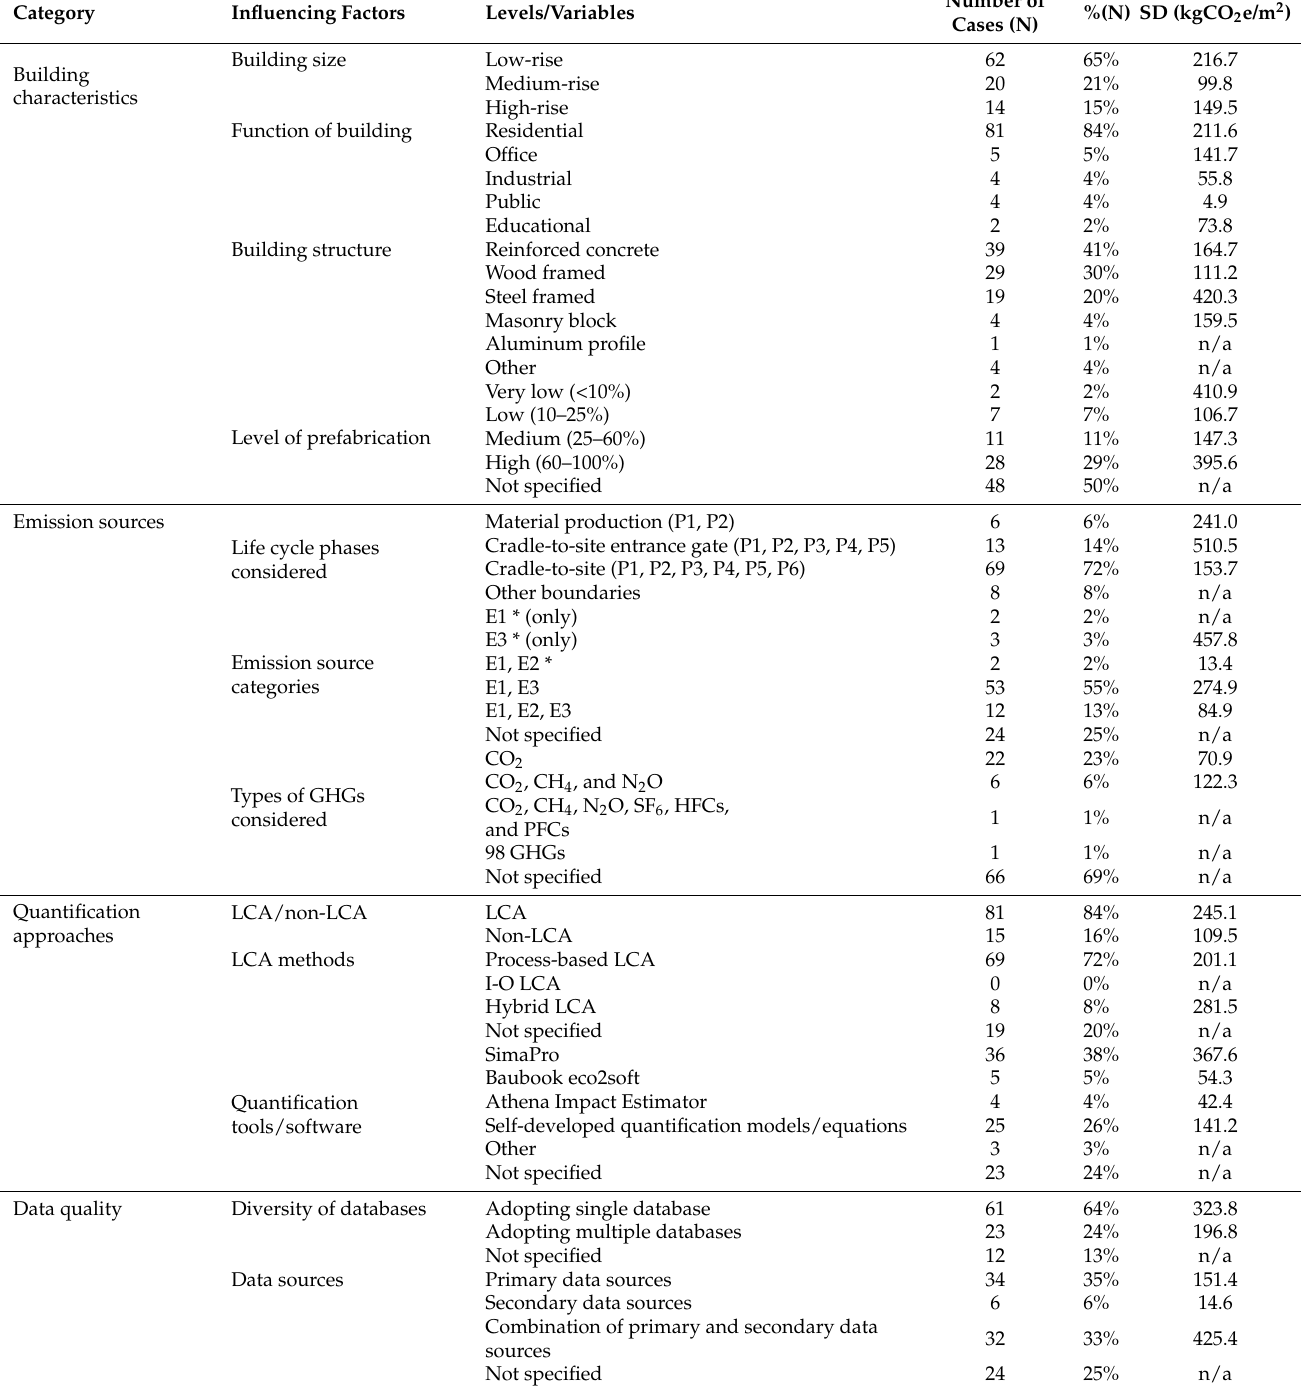
Table 2. Twelve influencing factors of embodied carbon quantification of prefabricated